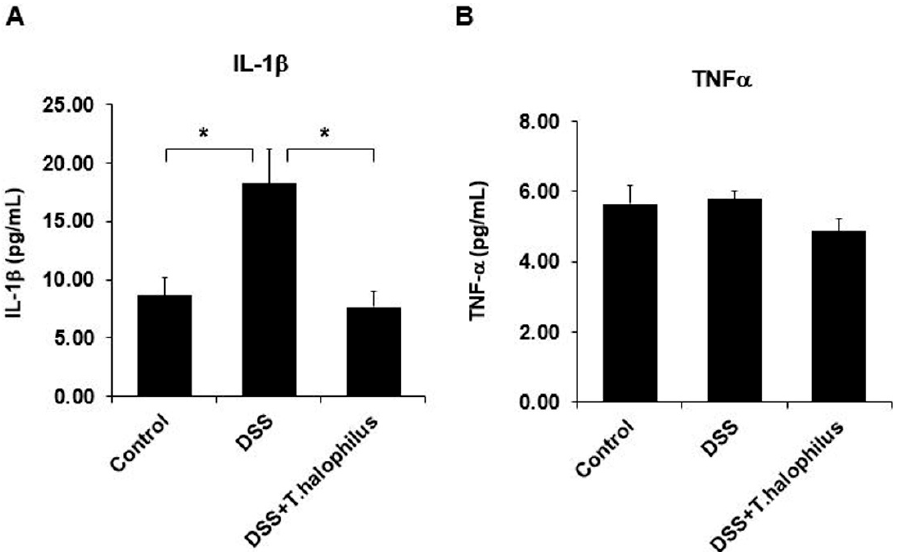
Figure 8. Effects of T. halophilus on plasma cytokine levels in DSS-induced colitis mice. Plasma IL-1 β and TNF α levels in normal control mice, DSS-induced colitis mice, and colitis mice treated with T. halophilus were analyzed by ELISA ( A , B ). Four mice were used in each experimental group. The experiment was performed in duplicate. Significantly different p- values are indicated by an asterisk as follows: *, p < 0.05.